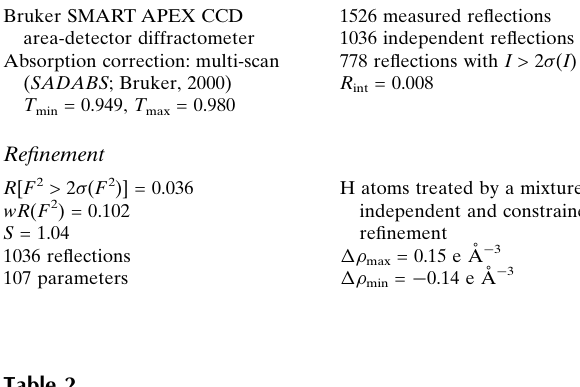
Hydrogen-bond geometry (A˚ , (cid:2)